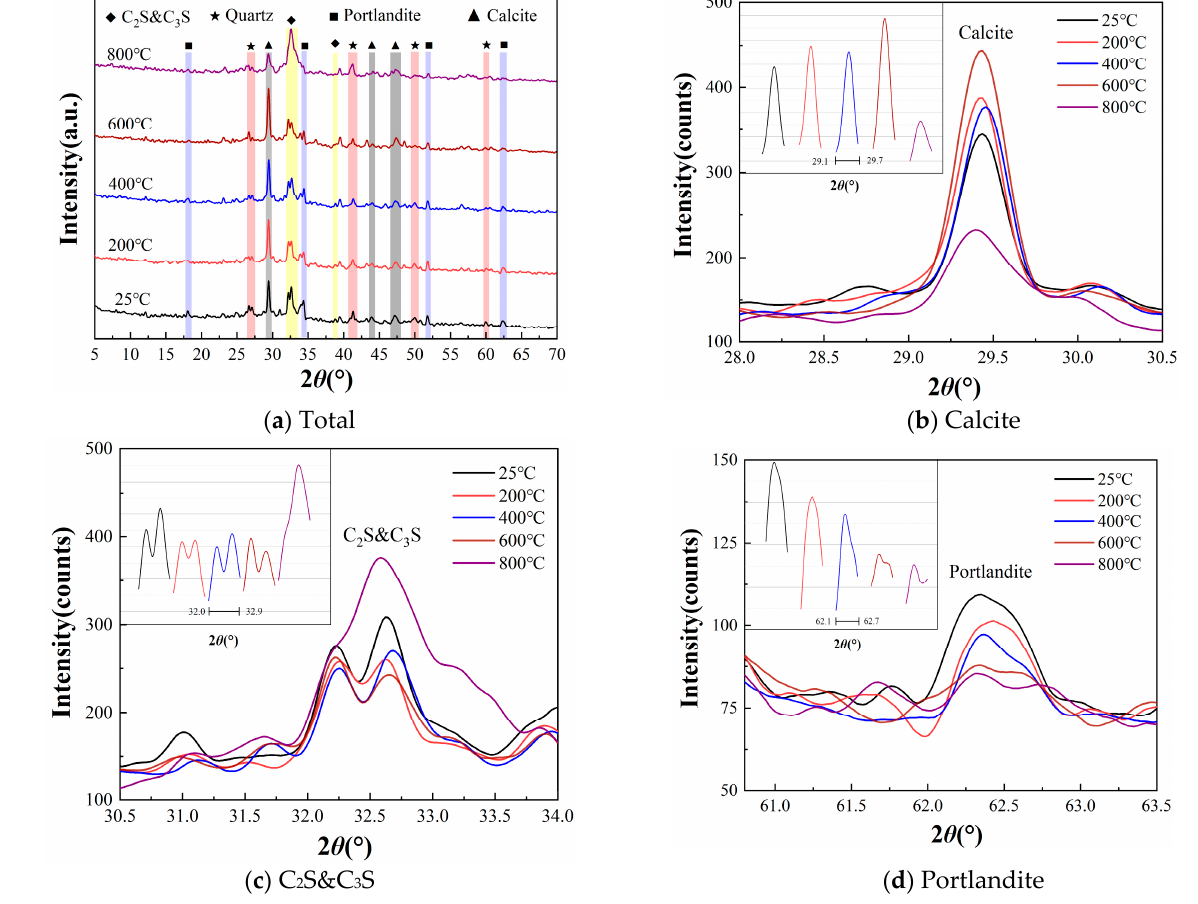
Figure 11. Phase composition of UHPC after exposure to high temperatures.